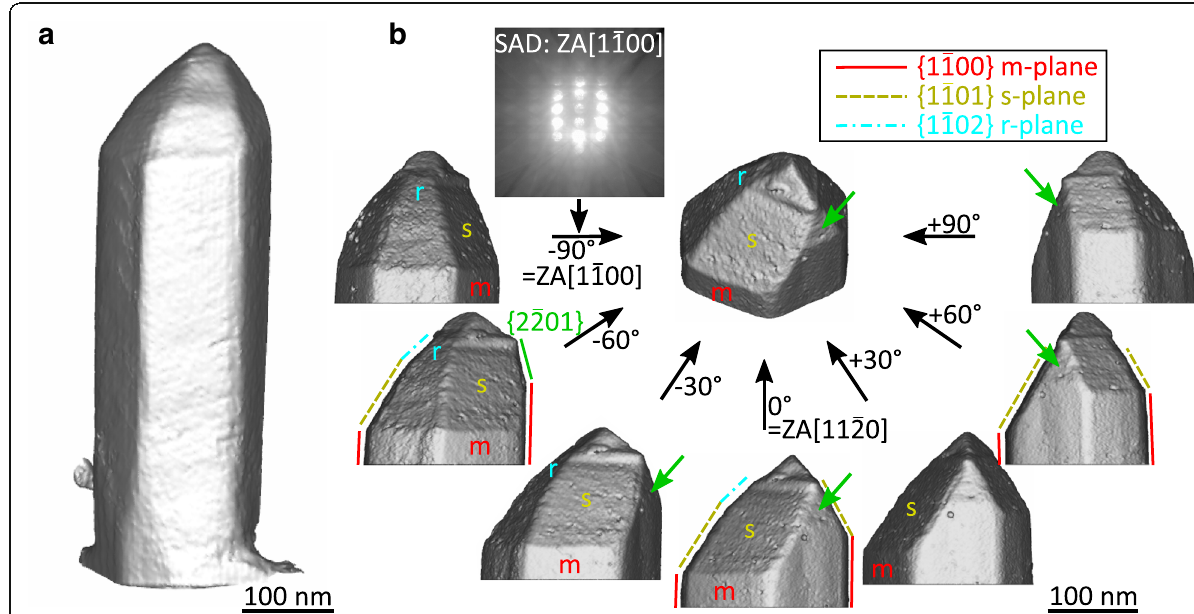
Fig. 3 Isosurface representation of a a single NW and b a NW apex with a perspective view in the center and various viewing angles along low index directions of GaN (ZA, zone axis). Additionally, some exemplary m -, s -, and r -plane facets are labeled (green arrows indicate a facet of f 2201 g